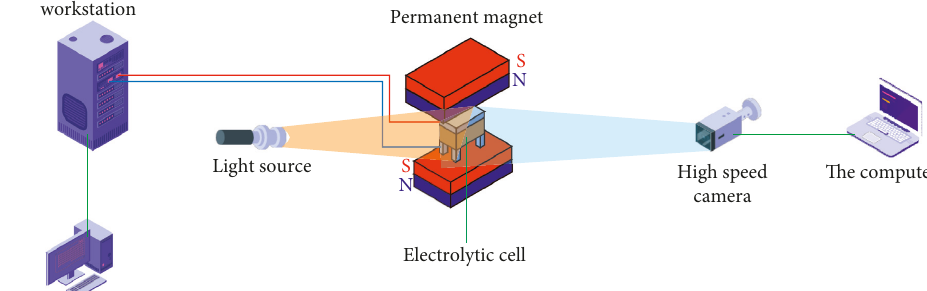
Figure 2: Experimental system diagram.